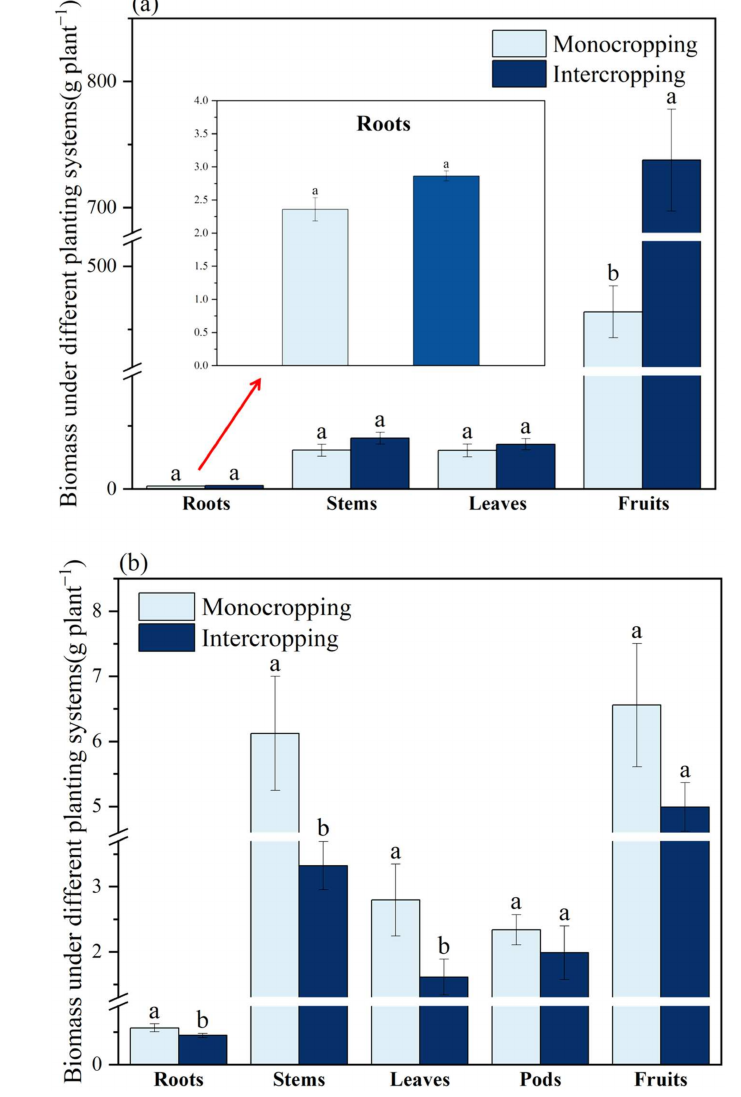
Figure 2. Biomass of L. cylindrica ( a ) and S. cassiae ( b ) in different planting systems. Different lowercase letters indicate significant ( p < 0.05) differences between the treatments according to Duncan’s